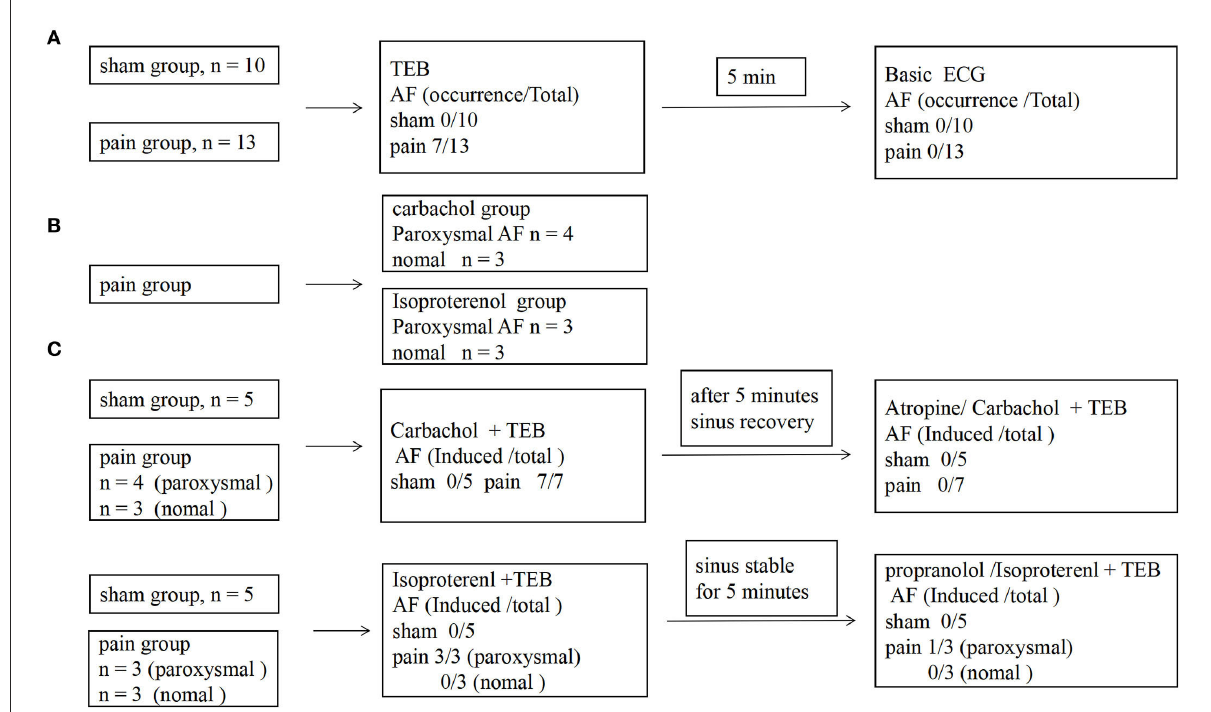
FIGURE3 The protocol for investigating electrophysiological characteristics, atrial susceptibility, and the occurrence of atrial fibrillation. (A) The protocol and results of the AF susceptibility by transesophageal burst pacing (TEB) in sham and pain groups; (B) the grouping scheme of pain group; (C) the protocol and results of the effects of the autonomic nervous system in AF susceptibility between sham and pain groups.